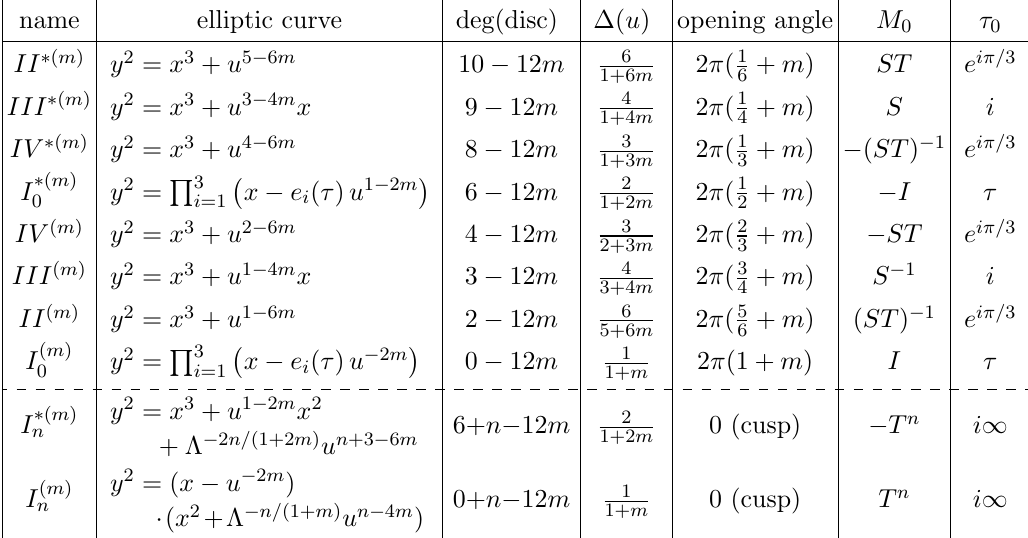
and I (cid:3) ( m ) n series